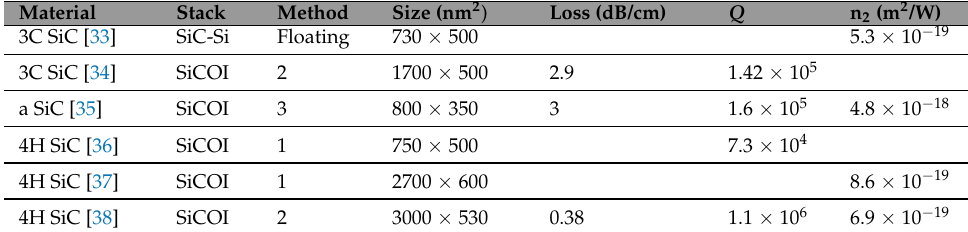
Table 2. State of the art of SiC waveguides.